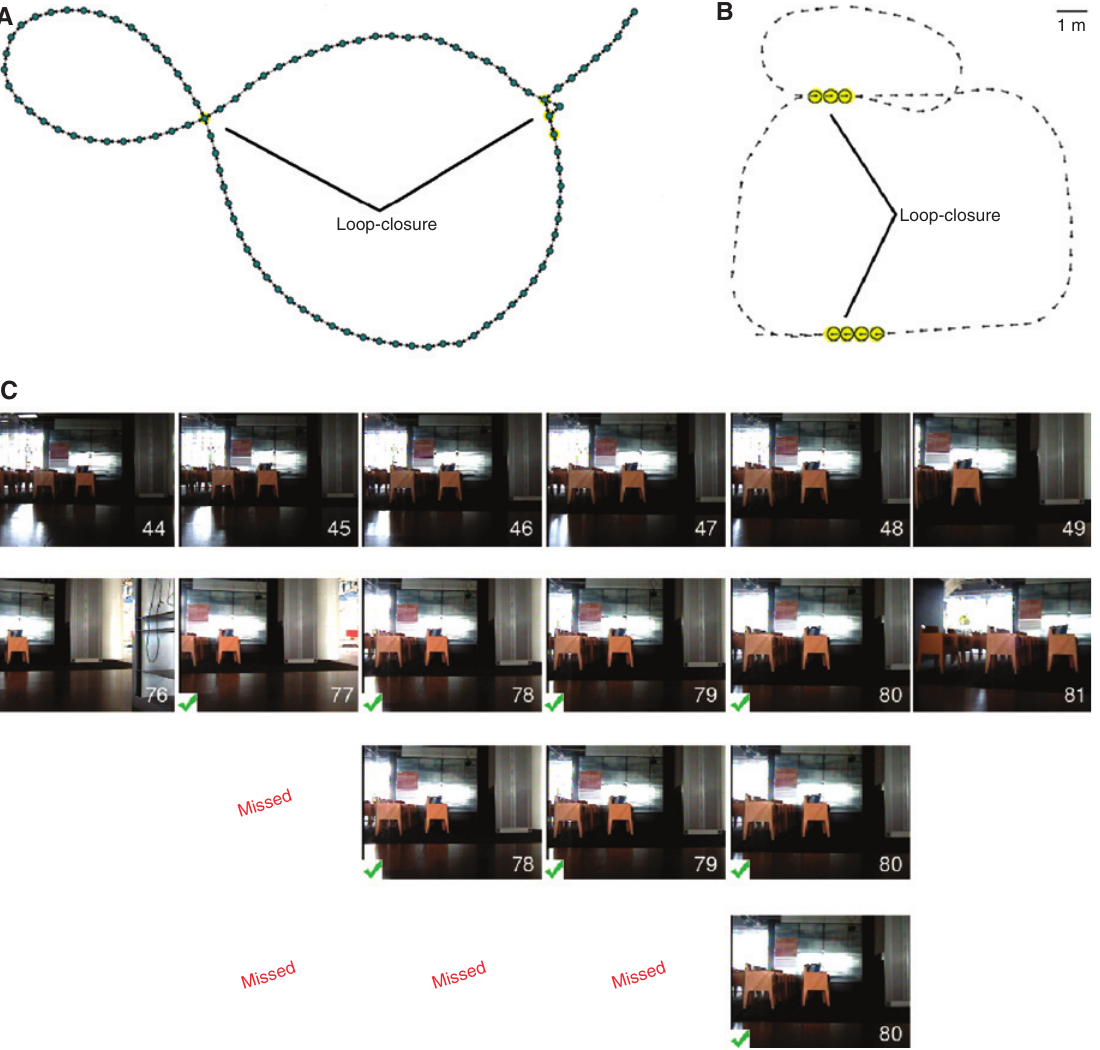
Figure 1. Museum